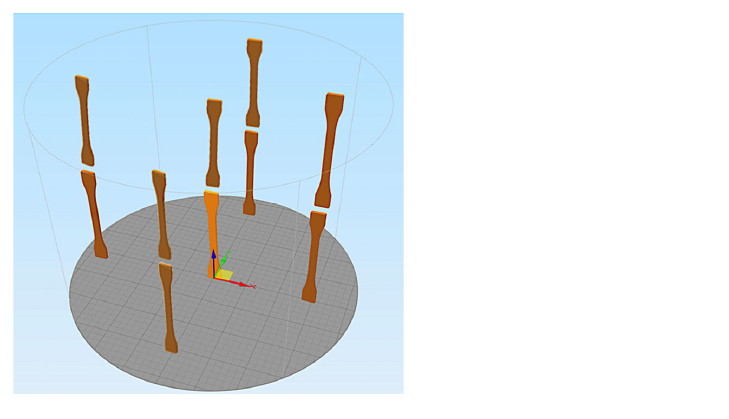
Figure 2. Samples of group B were printed in different positions on the build job. An overview of all groups, including their number of samples, their subgroups, and differences in production strategy, is given in Table 1. PEEK 3D-printed parts were manufactured at one per build. Table 1. Printed parts were divided into two main groups considering different printing strategies.